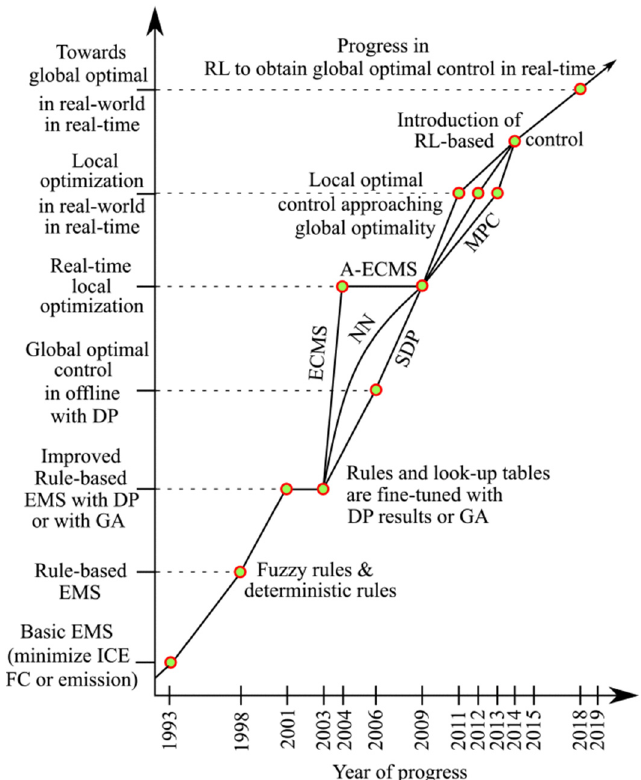
Figure 1. Tentative evolution of EMSs from 1993 to 2018 [9]. (ICE—internal combustion engine, FC—fuel consumption, DP—dynamic programming, GA—genetic algorithm, NN—neural networks, SDP, stochastic dynamic programming, A-ECMS—adaptive equivalent consumption minimization strategy, MPC—model predictive control, RL—reinforcement learning).